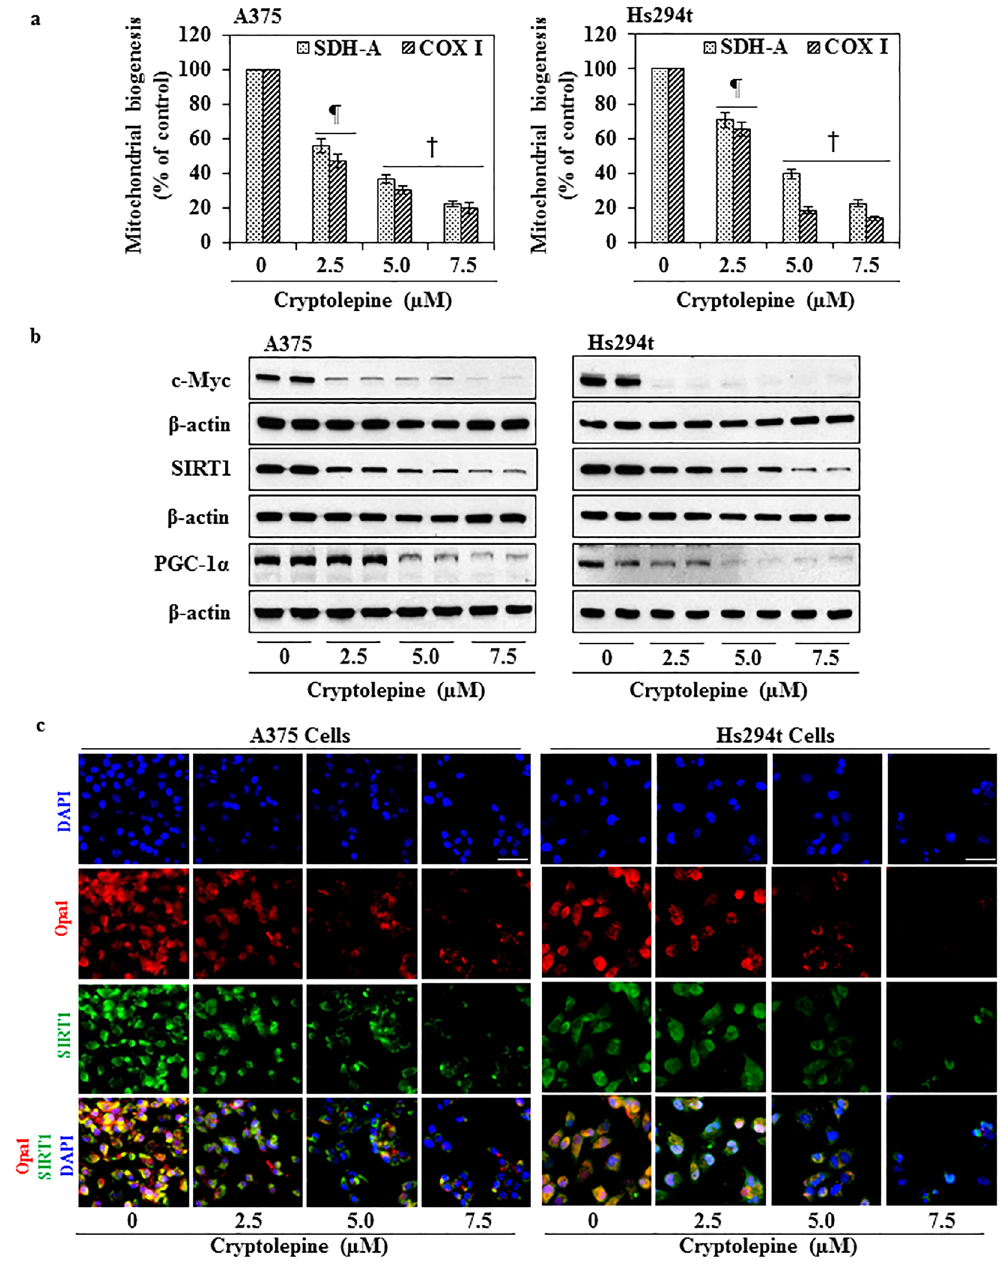
Figure 6. Treatment with cryptolepine inhibits mitochondrial biogenesis and associated molecular targets in melanoma cells. ( a ) Mitochondrial biogenesis in cryptolepine-treated and non-treated A375 and Hs294t cells was determined by measuring the levels of SDH-A and COX-I protein expression using the Mitochondrial Biogenesis Kit according to the manufacturer’s protocol. The experiment was performed two times. Protein expression in the vehicle-treated control group was considered as 100%. Statistical significance versus control, ¶ P < 0.01 and † P < 0.001. (b) After treatment of cells with cryptolepine for 24 h, total cell lysates from A375 and Hs294t cells were prepared and subjected to western blot analysis to determine the levels of proteins involved in mitochondrial biogenesis. Equal loading of proteins was verified by stripping the membrane and reprobing with β -actin antibody. (c) Immunofluorescence staining for the detection of Opa1-positive and SIRT1-positive cells was performed as detailed in Materials and Methods. Photomicrographs were obtained using Keyence Fluorescence Microscope BZ-X710 (Keyence Corporation of America). Representative photomicrographs are